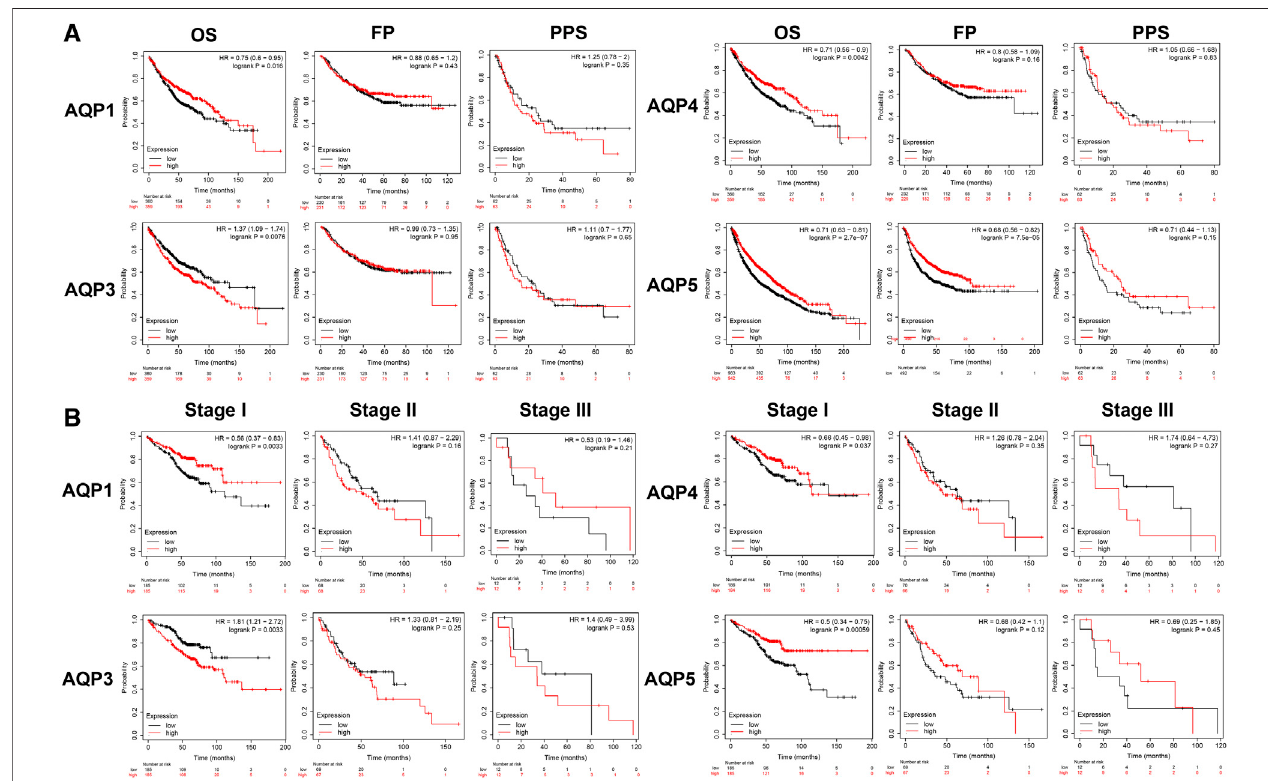
FIGURE 3 | Prognostic analysis of AQP family members in LUAD patients. (A) Kaplan – Meier analysis of prognostic effect of AQPs with OS, FP, and PPS values in LUAD patients. (B) Prognostic analysis of clinicopathologic factors for OS in AQPs. OS, overall survival; FP, fi rst progression survival; PPS, post-progression